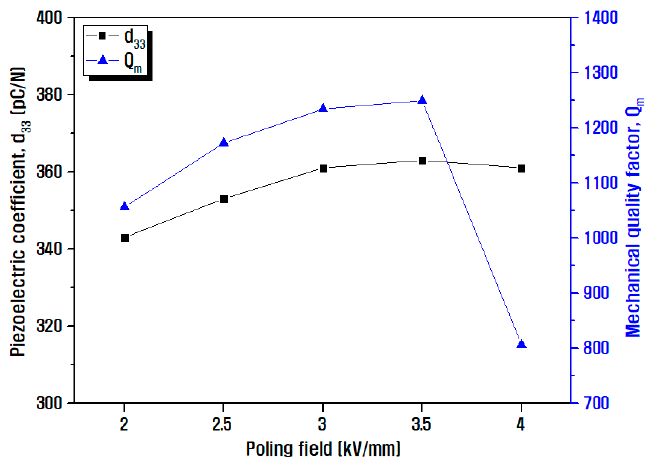
Figure 8. Electrical properties measurement results of the ceramic represented by d 33 and Q m with respect to the poling field. respect to the poling